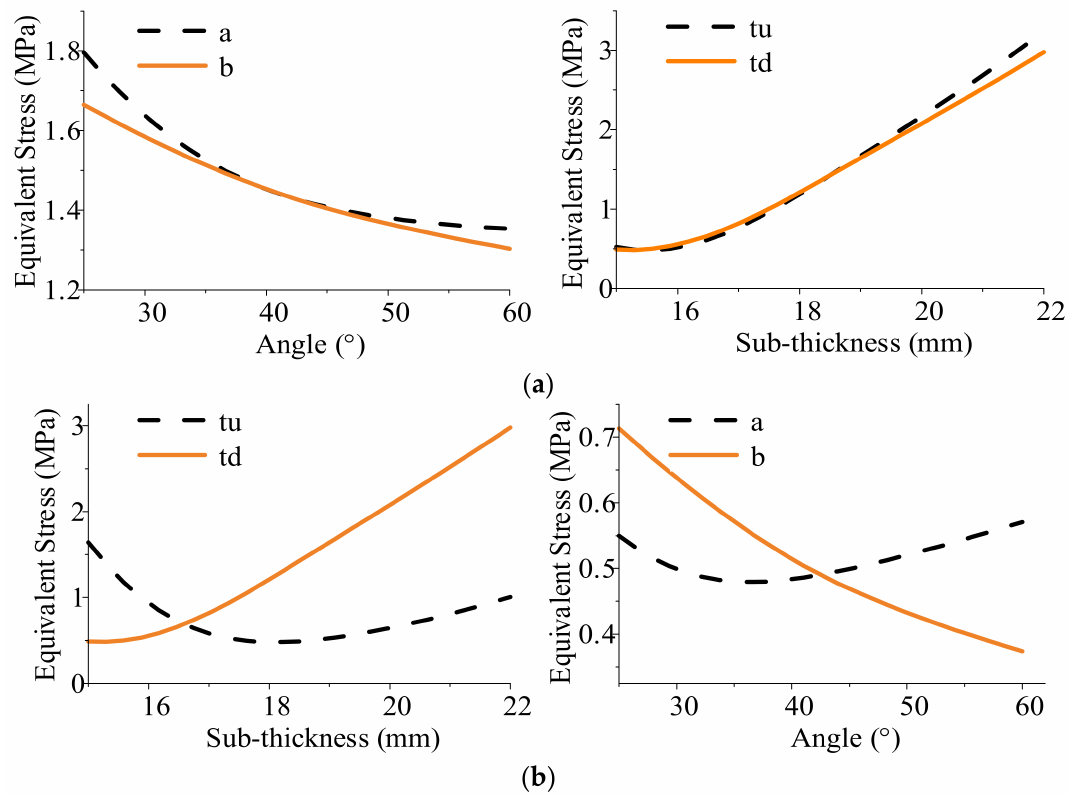
Figure 8. Relation between equivalent stress in the casing wall and each parameter. ( a ) Relation before the change of structural parameter; ( b ) Relation after the change of structural parameter.